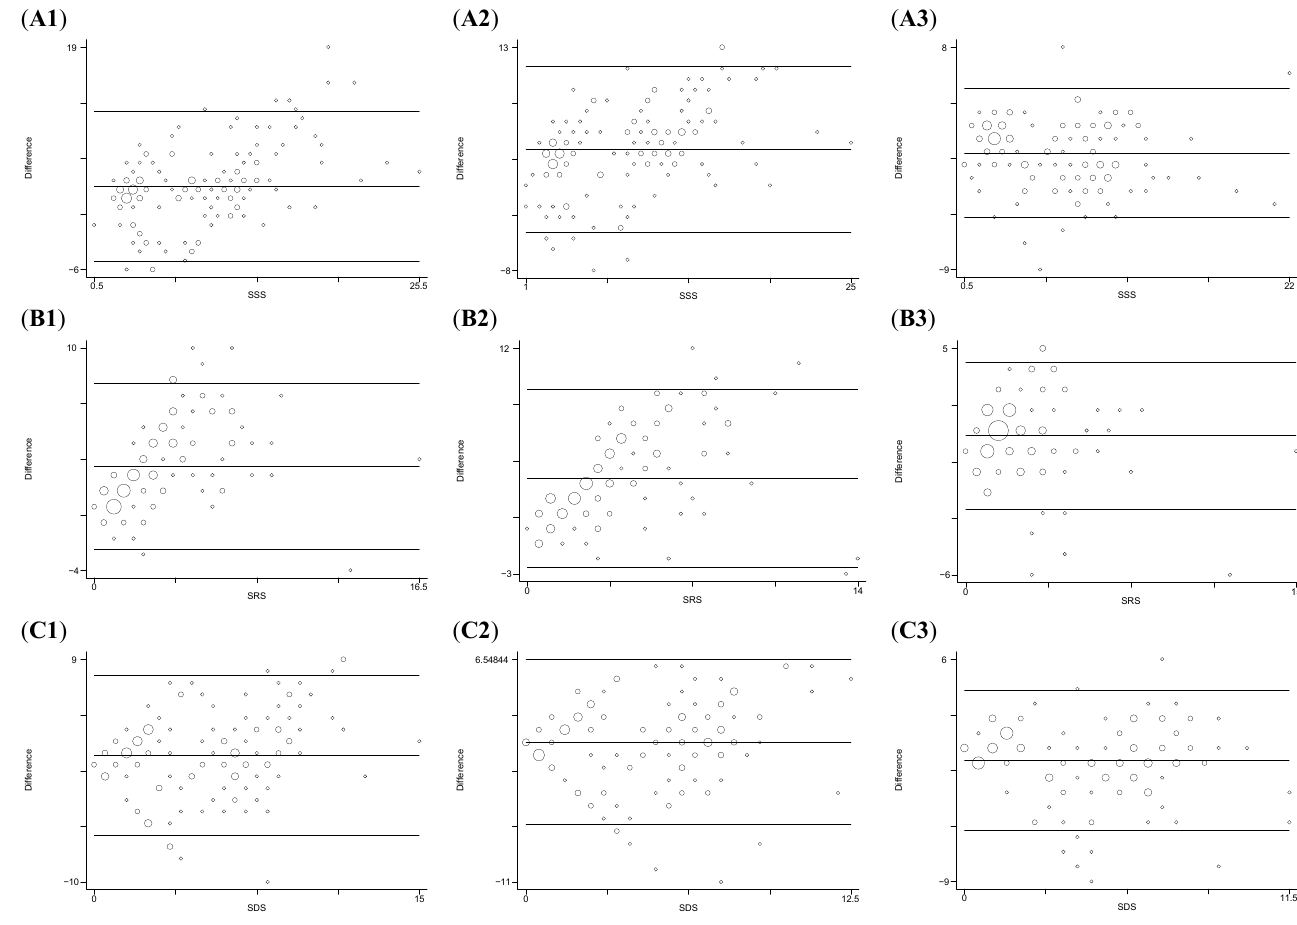
Figure 1. Bland–Altman Plots for ( A ) SSS, ( B ) SRS, and ( C ) SDS. 1, 2, 3 denote ECTb, MYO and QPS software packages, respectively. ECTb: Emory Cardiac Toolbox; MYO: Myovation; QPS: Quantitative Perfusion Single photon emission computed tomography; SDS: summed difference score; SRS: summed rest score; SSS: summed stress score. SSS values based on ER were significantly correlated with the corresponding results of all software packages (Table 4) and all coefficients were “strong”. Similarly, SRS and SDS values according to ER were significantly associated with SRS and SDS results from all software packages and correlations for SRS were almost all